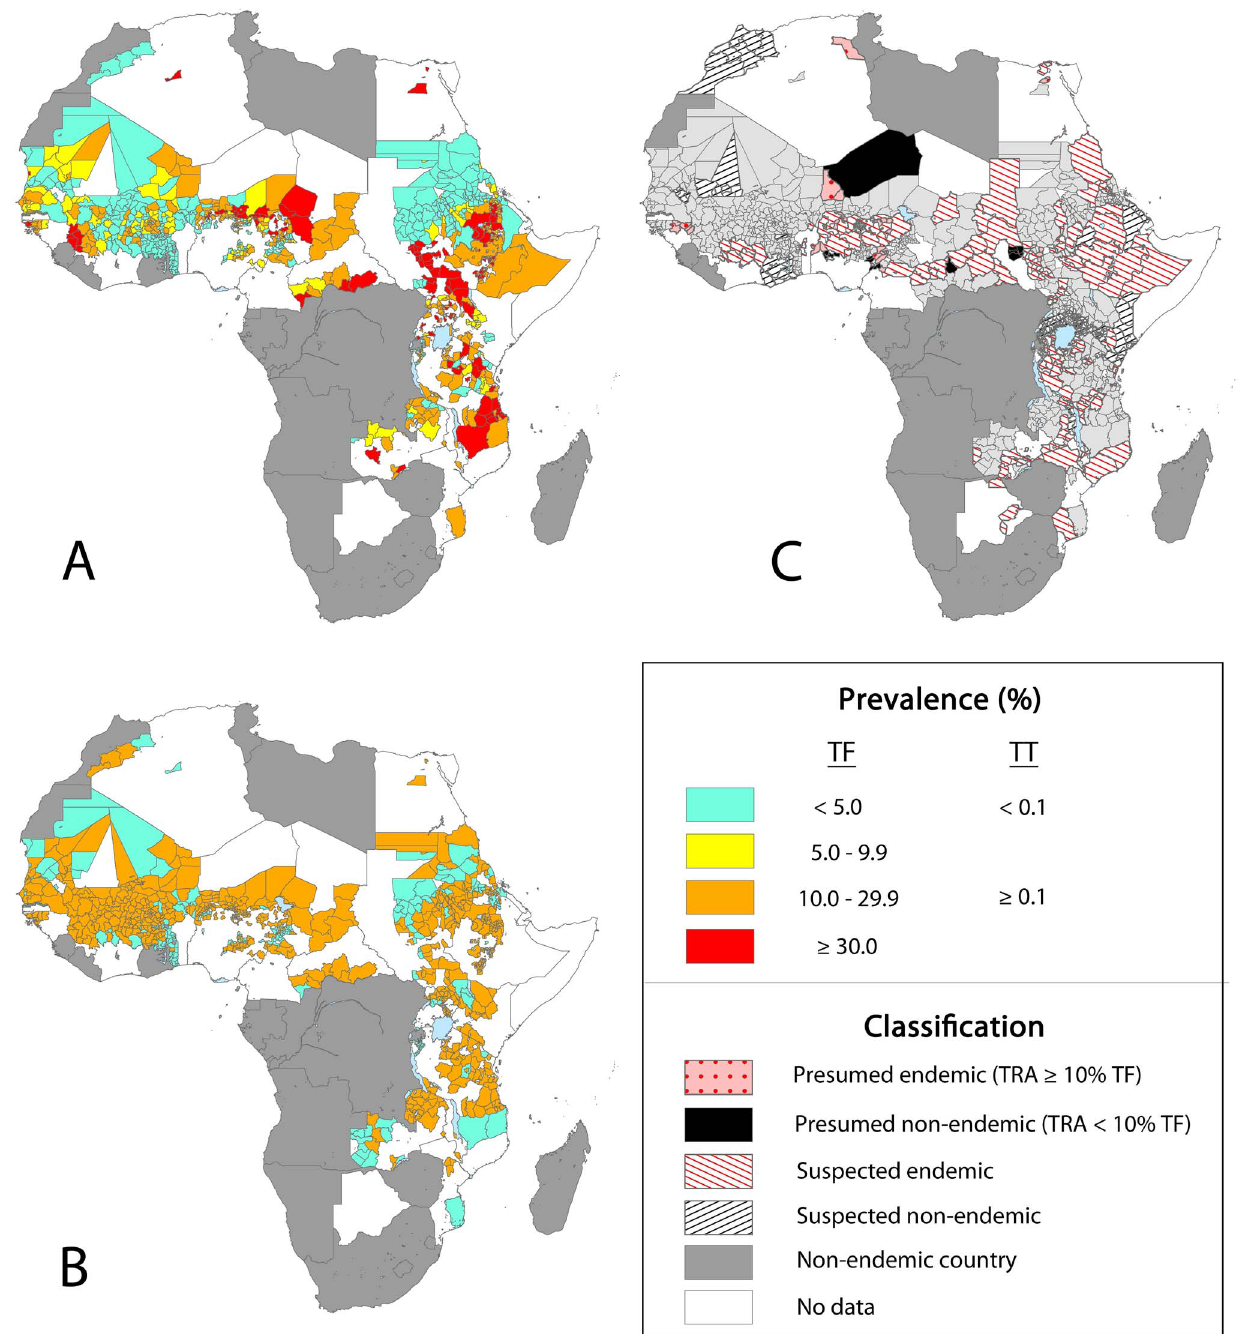
Figure 3. Empirical prevalence of A) trachomatous inflammation–follicular (TF) and B) trachomatous trichiasis (TT) and C) areas of suspected and presumed endemicity in Africa between 1985–2012. Population based prevalence surveys generated data for 1095 districts and 24 regions, while TRA surveys provided information on endemicity for 101 additional districts.